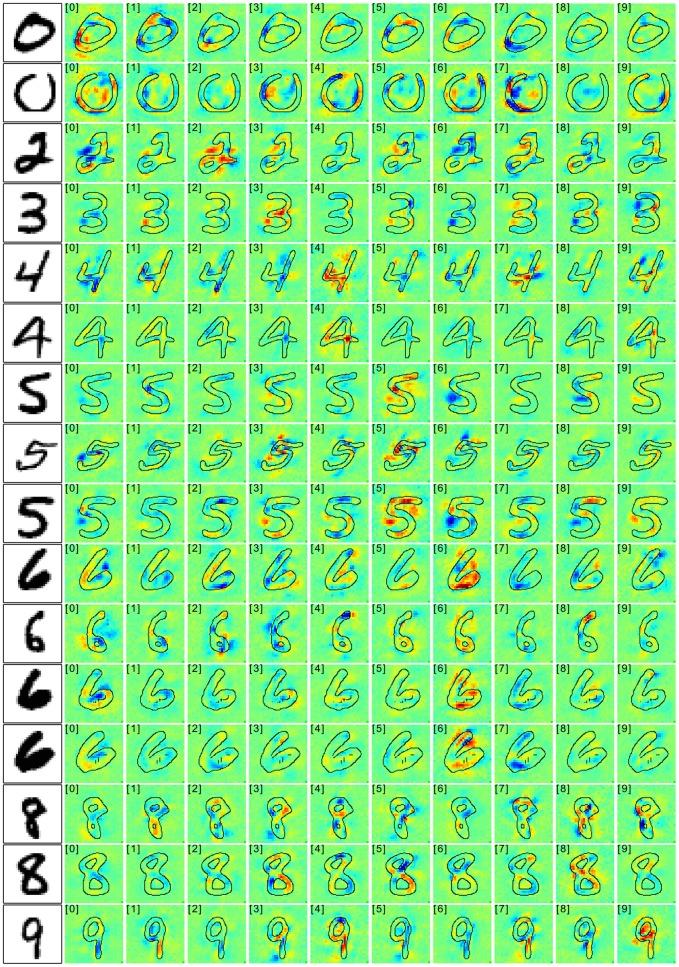
Pixel-wise decompositions for all classes for 16 randomly drawn digits from the MNIST test set.Results are obtained using the relevance propagation Formula (56) with the rectifying network trained for 1 000 000 iterations from Section MNIST experiments II.